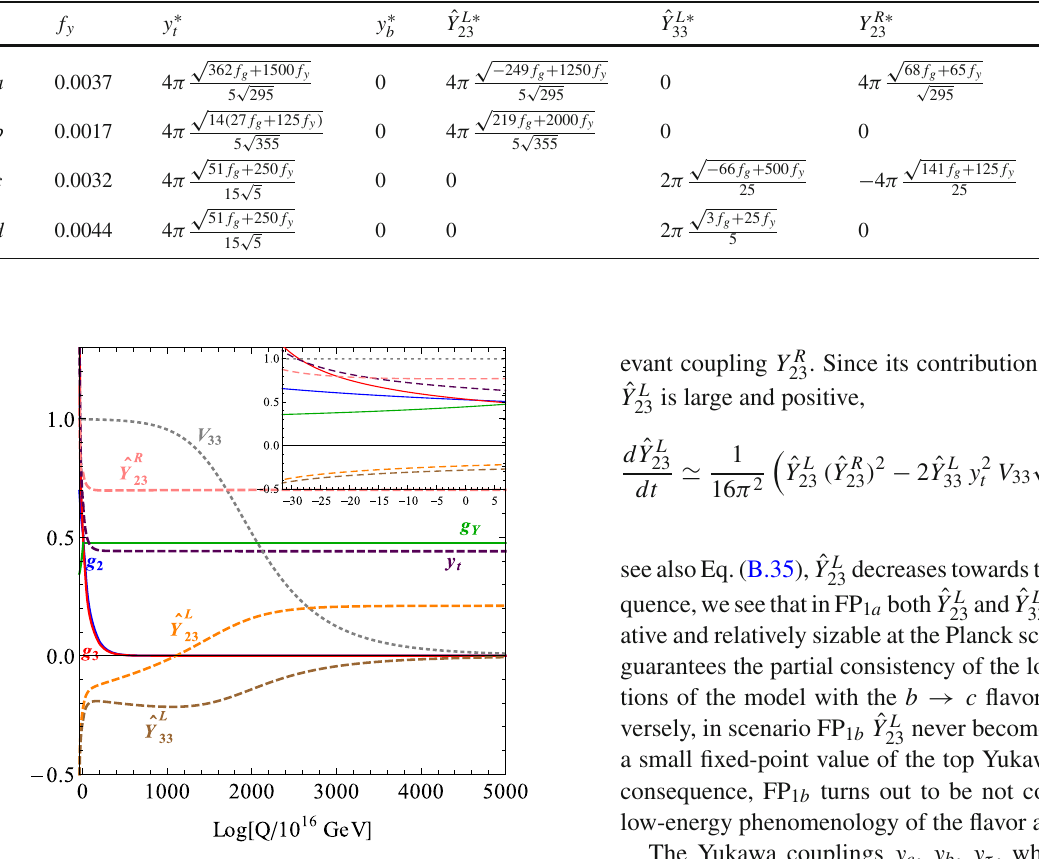
ˆ Y L duringits 33 ˆ Y L isverysmall 33 (cid:3) 0 . 2